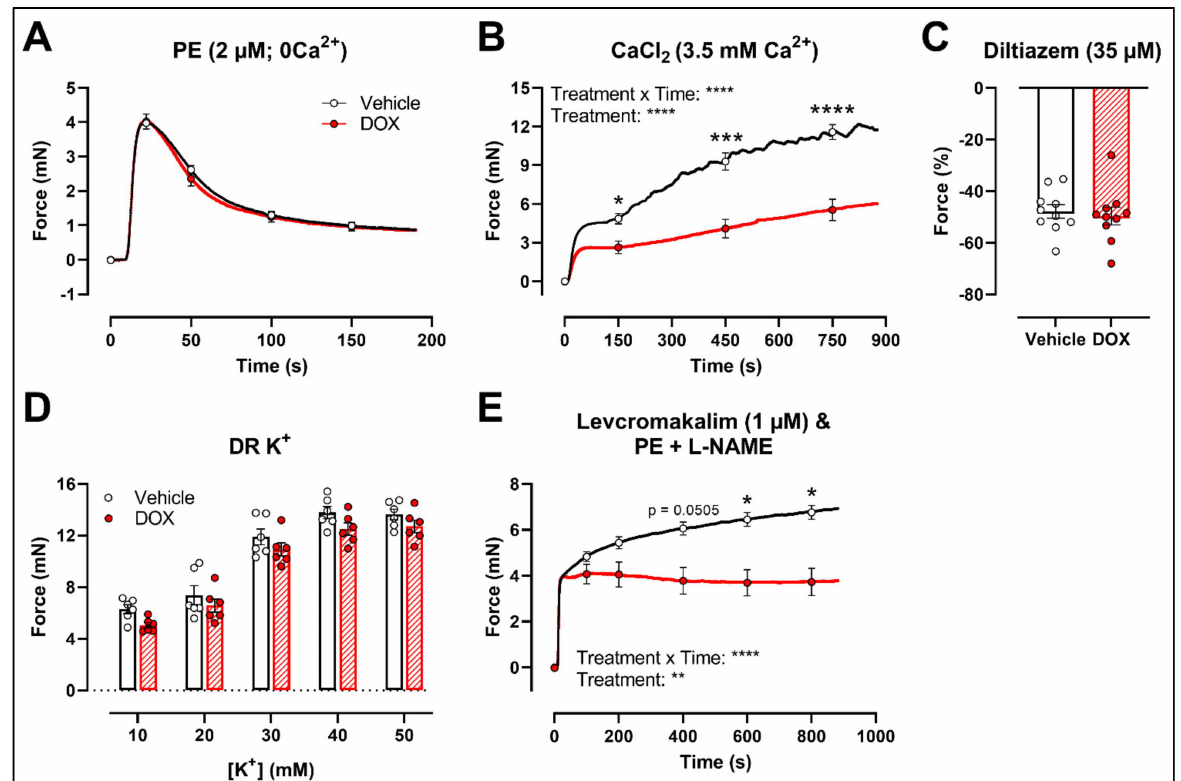
Figure 3. Contraction of aortic segments mediated by Ca 2+ release from the sarcoplasmic reticulum and Ca 2+ entry through VGCCs and NSCCs after 16 h of ex vivo DOX treatment. ( A ) Contraction through Ca 2+ release from the sarcoplasmic reticulum in response to PE (2 µ M) in the absence of extracellular Ca 2+ (0 mM Ca 2+ ). ( B ) Addition of 3.5 mM Ca 2+ after 0 mM Ca 2+ PE-elicited contraction. ( C ) Addition of 35 µ M diltiazem following stable CaCl 2 -mediated contraction. ( D ) Dose–response of K + -elicited contraction (10, 20, 30, 40 and 50 mM). ( E ) PE-induced contraction (with L-NAME) under levcromakalim (1 µ M). DOX did not change contraction through Ca 2+ release from the sarcoplasmic reticulum, nor Ca 2+ uptake and Ca 2+ efflux after 16 h of ex vivo DOX treatment ( A ), but VSMC contraction was decreased in the DOX-treated group after CaCl 2 addition ( B ). There was no difference in VSMC relaxation between the groups after blocking of VGCCs with diltiazem ( C ), nor in the contraction magnitude in response to different K + doses ( D ). DOX decreased PE-induced contraction (with L-NAME) in the presence of levcromakalim ( E ). For ( A , B , D , E ), repeated measures two-way ANOVA with Šid à k’s multiple comparisons test. For ( C ), unpaired t -test. *, ***, **** p < 0.05, 0.001, 0.0001; p > 0.05 in ( A , C , D ); ( A – C ) n = 10 in each group; ( D , E ) n = 6 in each